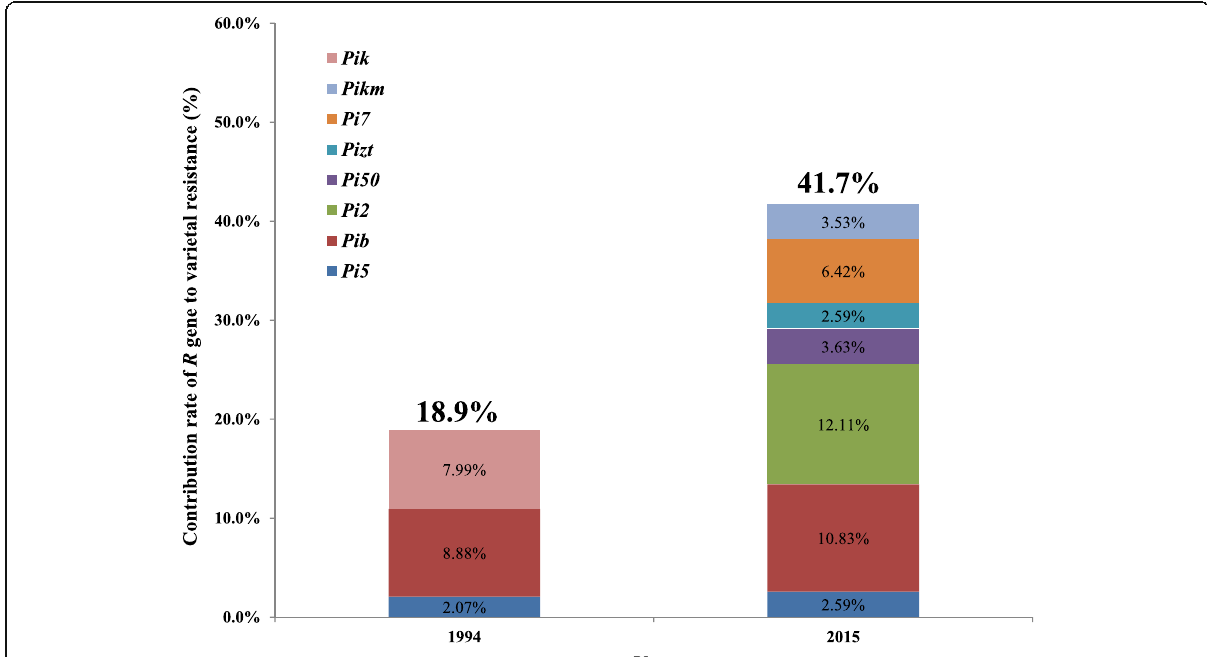
Fig. 3 Contribution of different R genes to the resistance of varieties in 1994 and 2015. The percentages of individual R genes contributed to the varietal resistance are indicated in colored boxes corresponding to the different R genes. The accrued percentage from individual R genes is indicated on the top of boxes for the years of 1994 and